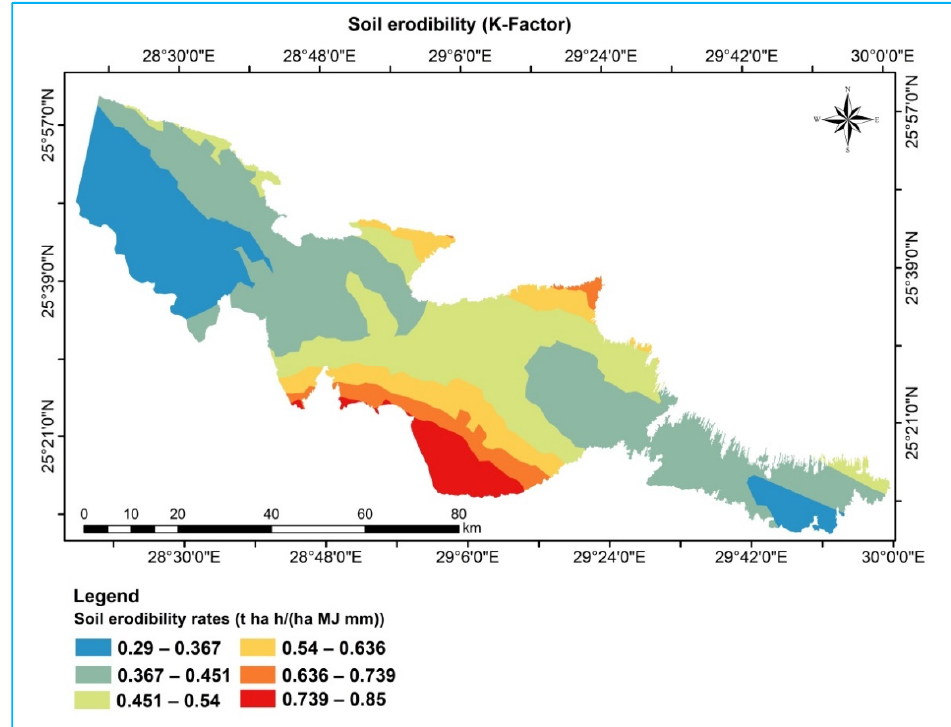
Figure 7. Spatial distribution map of soil erodibility factor (K-Factor).